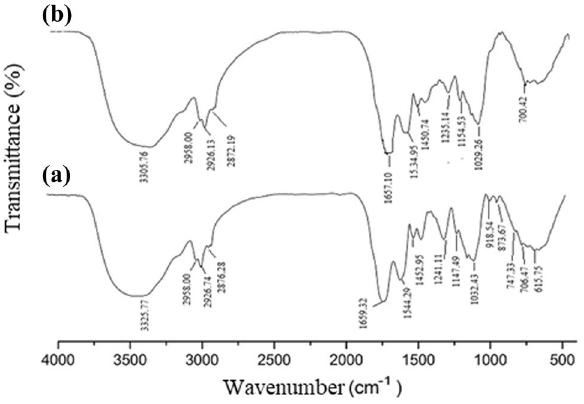
Fig. 2 FTIR Spectra of A Before and B After dye biosorption